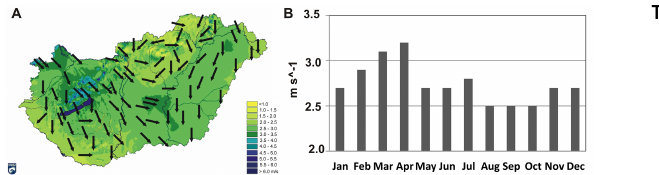
Figure 2. (a) Yearly average (in the period of 2000–2009) wind speed and dominant wind direction in Hungary (arrow lengths do not indicate wind speed, only the direction of dominant wind is shown) (source: MET, 2012b) and (b) the monthly average wind speeds at Budapest between 1998 and 2008 (source: MET, 2012c).